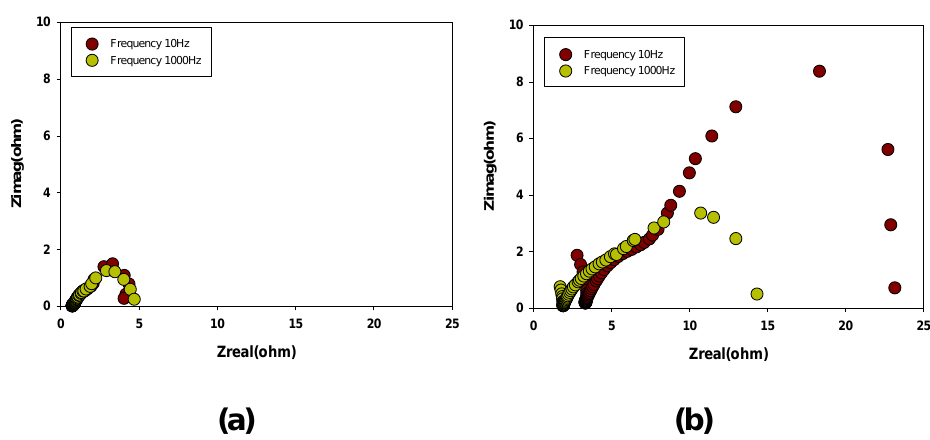
Figure 8. Impedance plots for DMFCs with the Au coated PCB substrate using a pulse electroplating method at various frequencies: ( a ) initial, ( b ) after test. Table 2. Electrochemical parameters from the impedance plots.